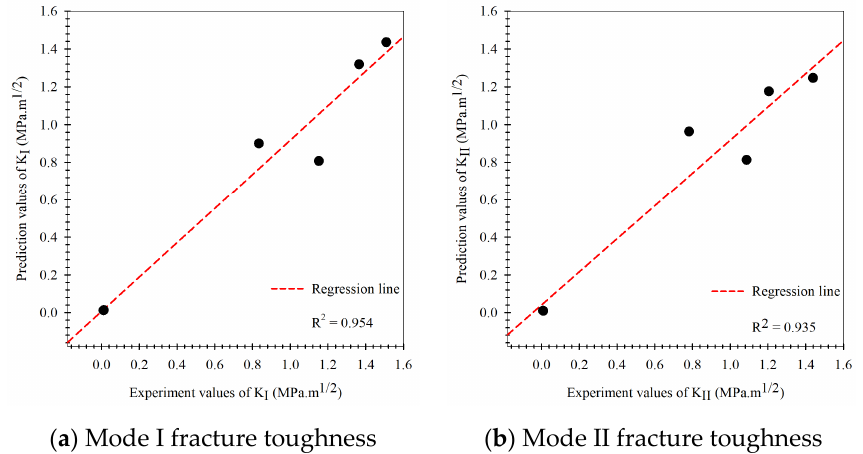
Figure 10. Prediction results of the multi-fidelity surrogate model based on the GMTS criteria compared to the experiment results.